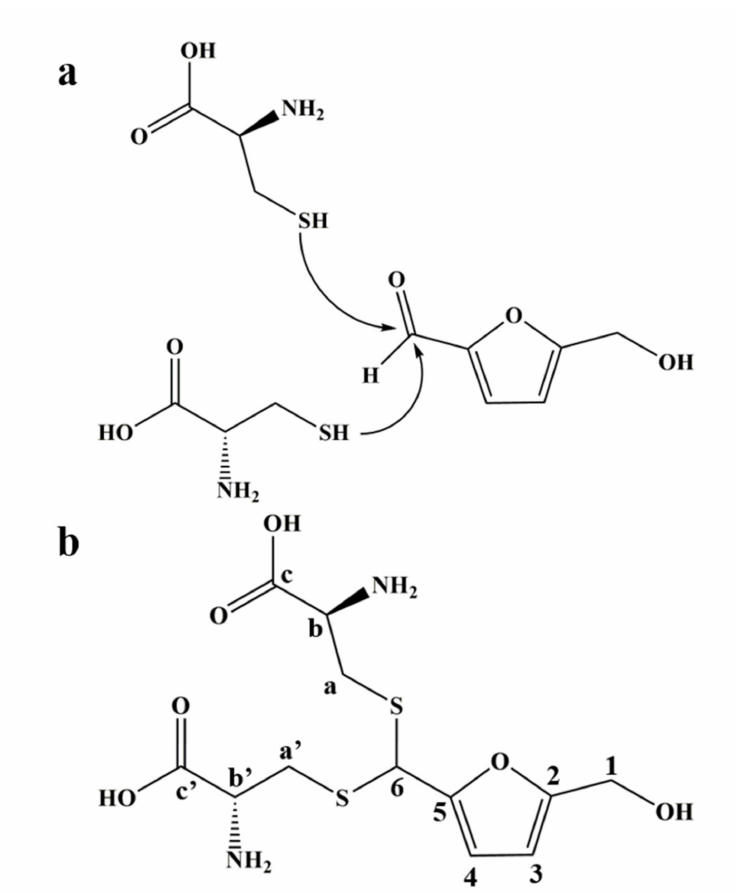
Figure 2. The reaction mechanism and the adduct structure of HMF and L-cys. ( a ) The sulfhydryl group of L-cys nucleophilically attacks the aldehyde carbon of HMF to cause a thioacetal reaction. ( b ) The structure of 1-dicysteinethioacetal–5-hydroxymethylfurfural (DCH) and label of carbon